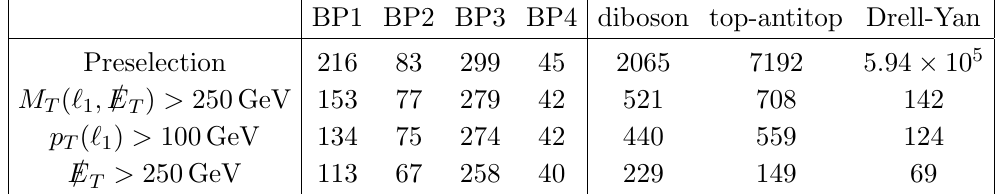
Table 4 . Number of events surviving each step of our selection strategy for the four signal bench- mark scenarios and the three main background components. We assume an integrated luminosity of 100 fb (cid:0) 1